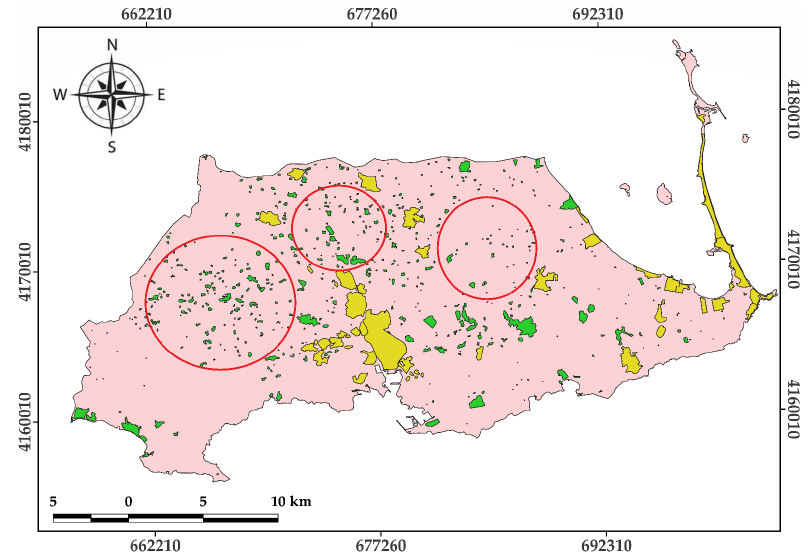
Figure 5. Small population centers for which self-composting could be proposed (own elabora- tion). 3.2.2. Home Composting or Self-Composting According to the study on waste management models in isolated rural